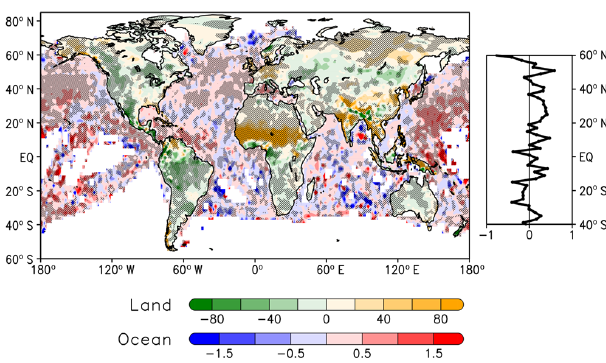
Figure 7. (Left) trend shifts in the humidity deficit (gkg − 1 10 years − 1 ) over the ocean and (right) latitude pro- file of its zonal mean. Land areas display trend shifts in JAS precipitation from Fig. 3a. Hatching represents areas where trends changed sign between the two parts of the study period (tan θ 1 · tan θ 2 <0).